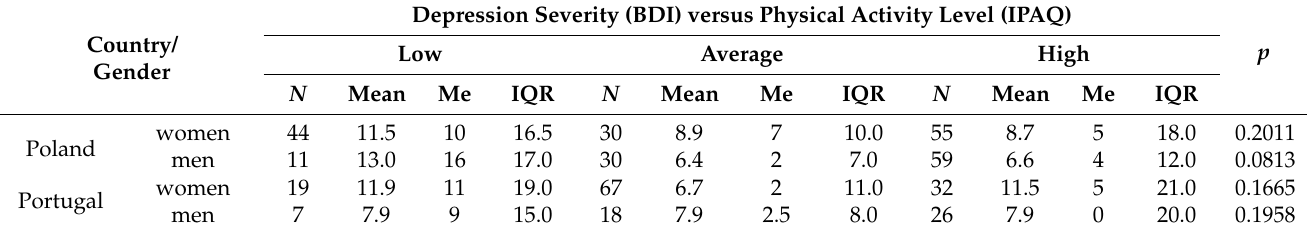
Table 8. Distribution of BDI in groups separated by physical activity